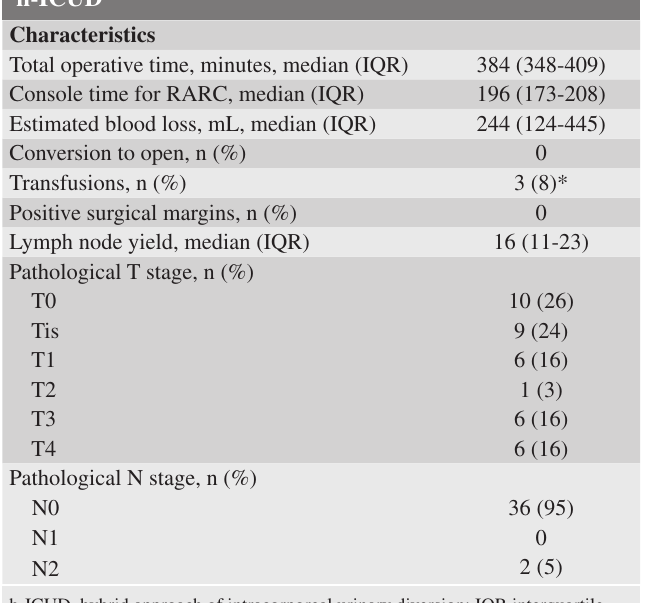
Table 2. Intraoperative Details and Pathological Outcomes of 38 Patients who Underwent RARC with